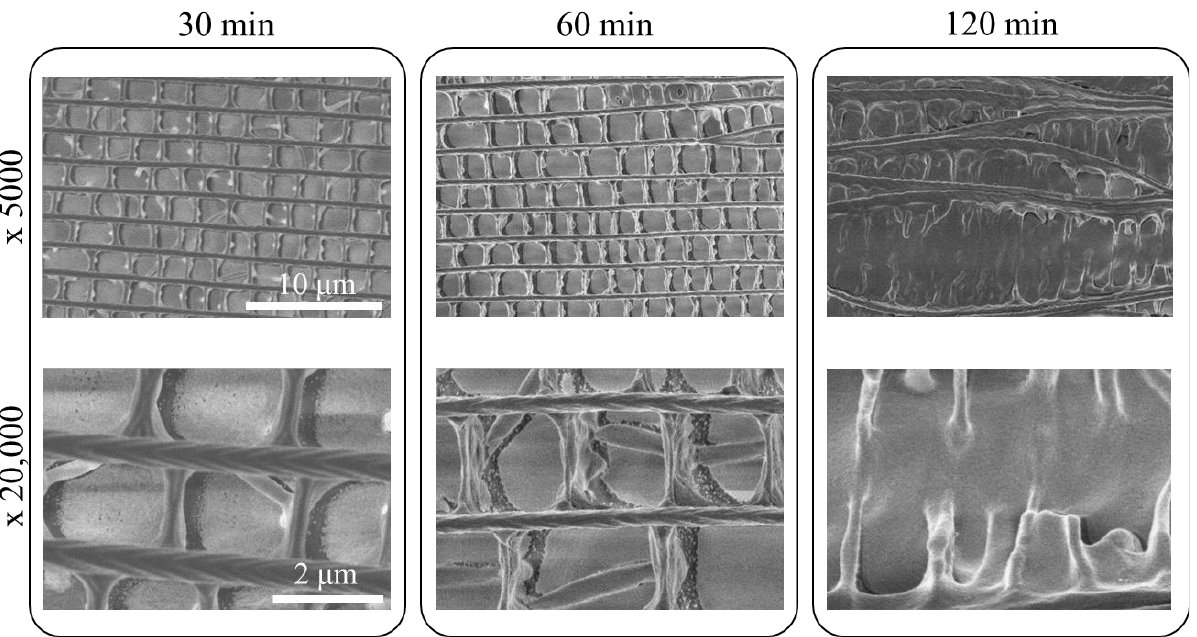
Figure 6. SEM images (Hitachi SU8030) of chestnut scales treated with ozone for 30-, 60- and 120-min. Scale bars: 10 µm (upper row) and 2 µm (lower row).